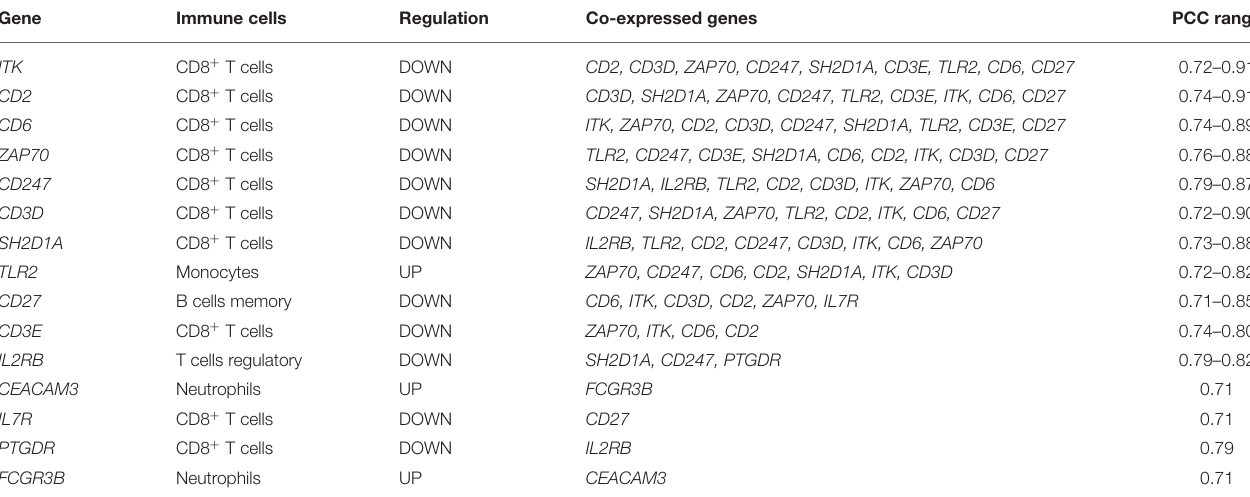
TABLE 2 | List of co-expressed genes and the druggable targets. Gene